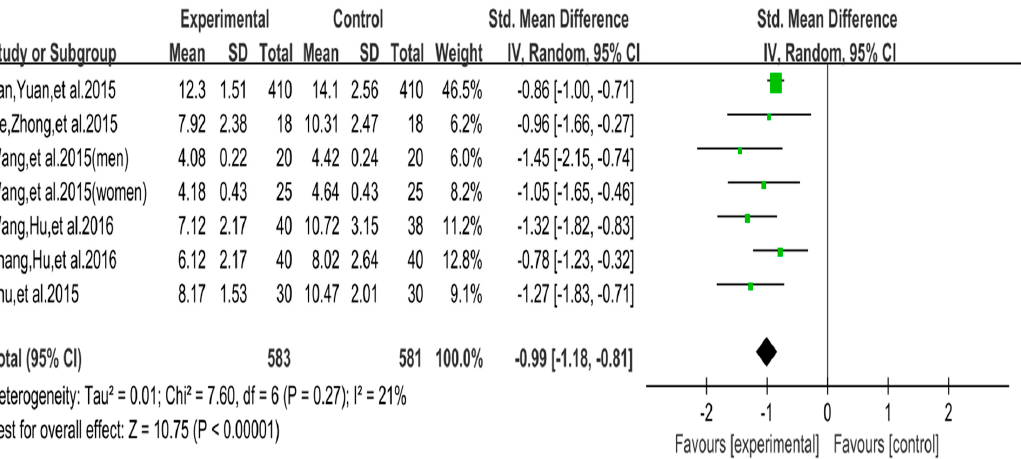
Figure 8. Funnel plot for publication bias of social comfort.